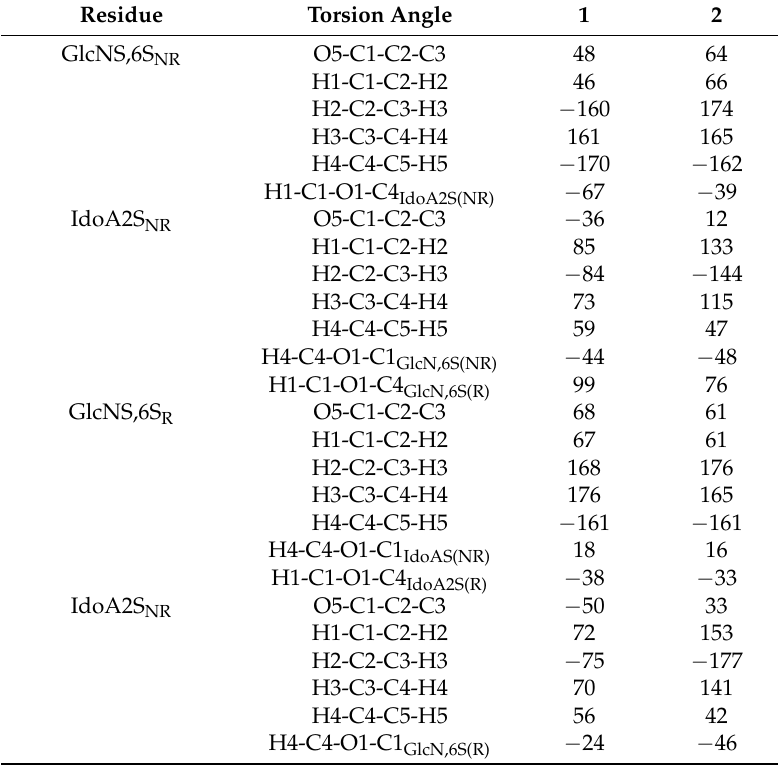
Table 2. Selected optimised (B3LYP/6-311++G(d,p)) torsion angles (in degrees) in the heparin tetrasaccharide. Two conformers of the IdoA2S residues are considered: 1 C 4 and 2 S 0 to provide, respectively, two forms of the heparin tetrasaccharide, ( 1 ) and ( 2 ). The GlcNS,6S residues are in the 4 C 1